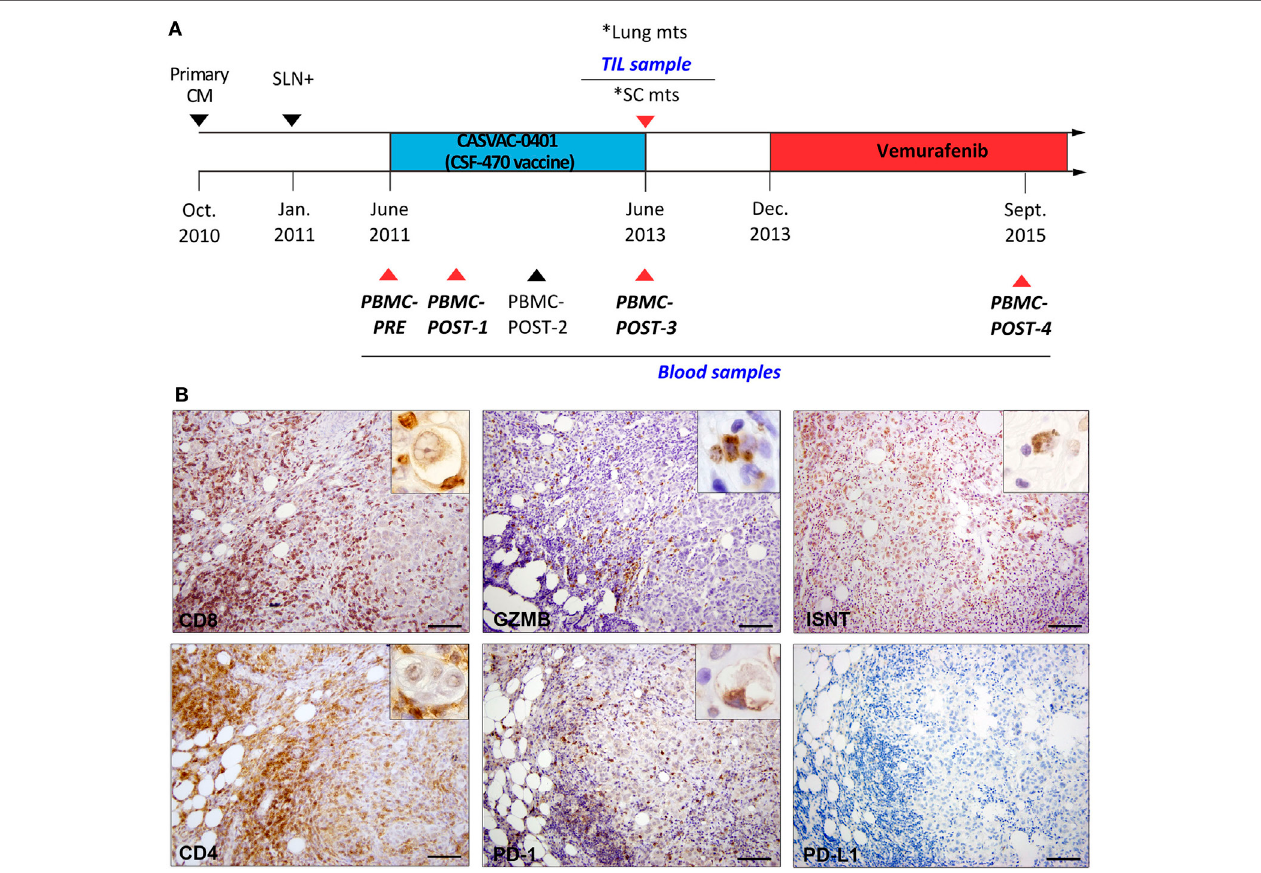
FIGURe 1 | Patient #006 timeline and immune infiltrate analysis in post-vaccination subcutaneous metastasis (SC mts). (a) The patient was randomized to the CSF-470 vaccine arm of CASVAC-0401 study. Tumor resections of primary tumor, sentinel node, and SC mts are indicated by triangles. Peripheral blood mononuclear cell (PBMC) samples were obtained at 0 (PBMC-PRE), 6 (PBMC-POST-1), 12 (PBMC-POST-2), 24 (PBMC-POST-3), and 48 months (PBMC-POST-4) from vaccine protocol. *Lung and SC mts were detected at the same time; tumor-infiltrating lymphocytes (TIL) were obtained from the SC mts. Samples selected for T-cell receptor β sequencing are indicated with red triangles and in italics. (B) Representative pictures of the same region in the SC mts after IHC staining for CD8, Granzyme-B (GZMB), in situ nick translation (ISNT), CD4, PD-1, and PD-L1 are shown (DAB, brown). Insets show positive staining under high magnification (1,000 × ). Scale bars = 100